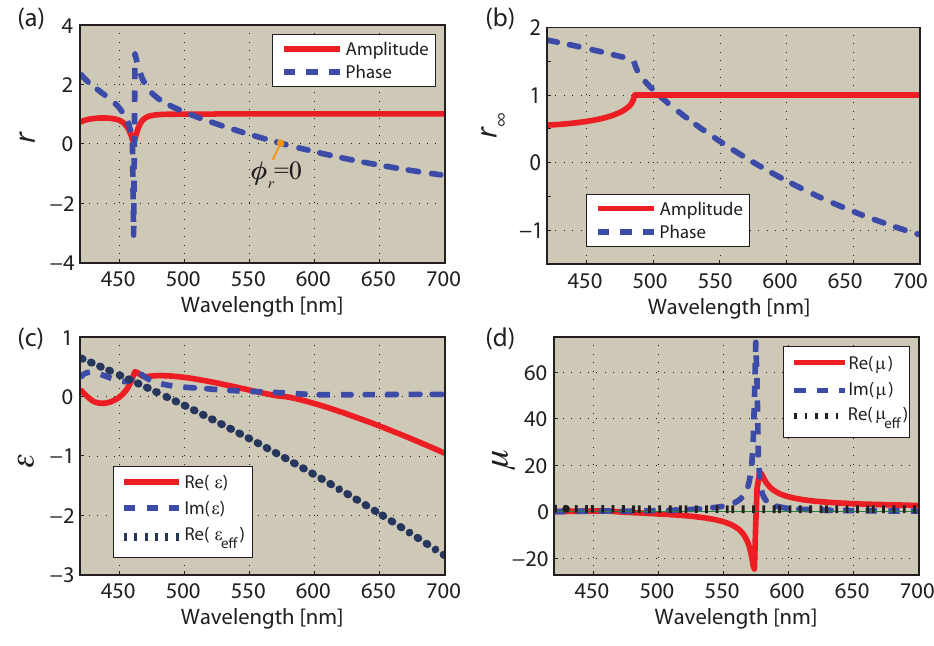
Figure 1. A case of spurious constitutive parameter retrieval. ( a ) The reflection coefficient from a slab formed by ten alternating layers of dielectric and metal having thicknesses of l = 30 nm and l = 60 nm, respectively; ( b ) reflection coefficient from a semi-infinite d m structure formed by the same layers; ( c ) retrieved permittivity and ( d ) permeability, along with theoretical predictions. The material parameters are the same as those used throughout the